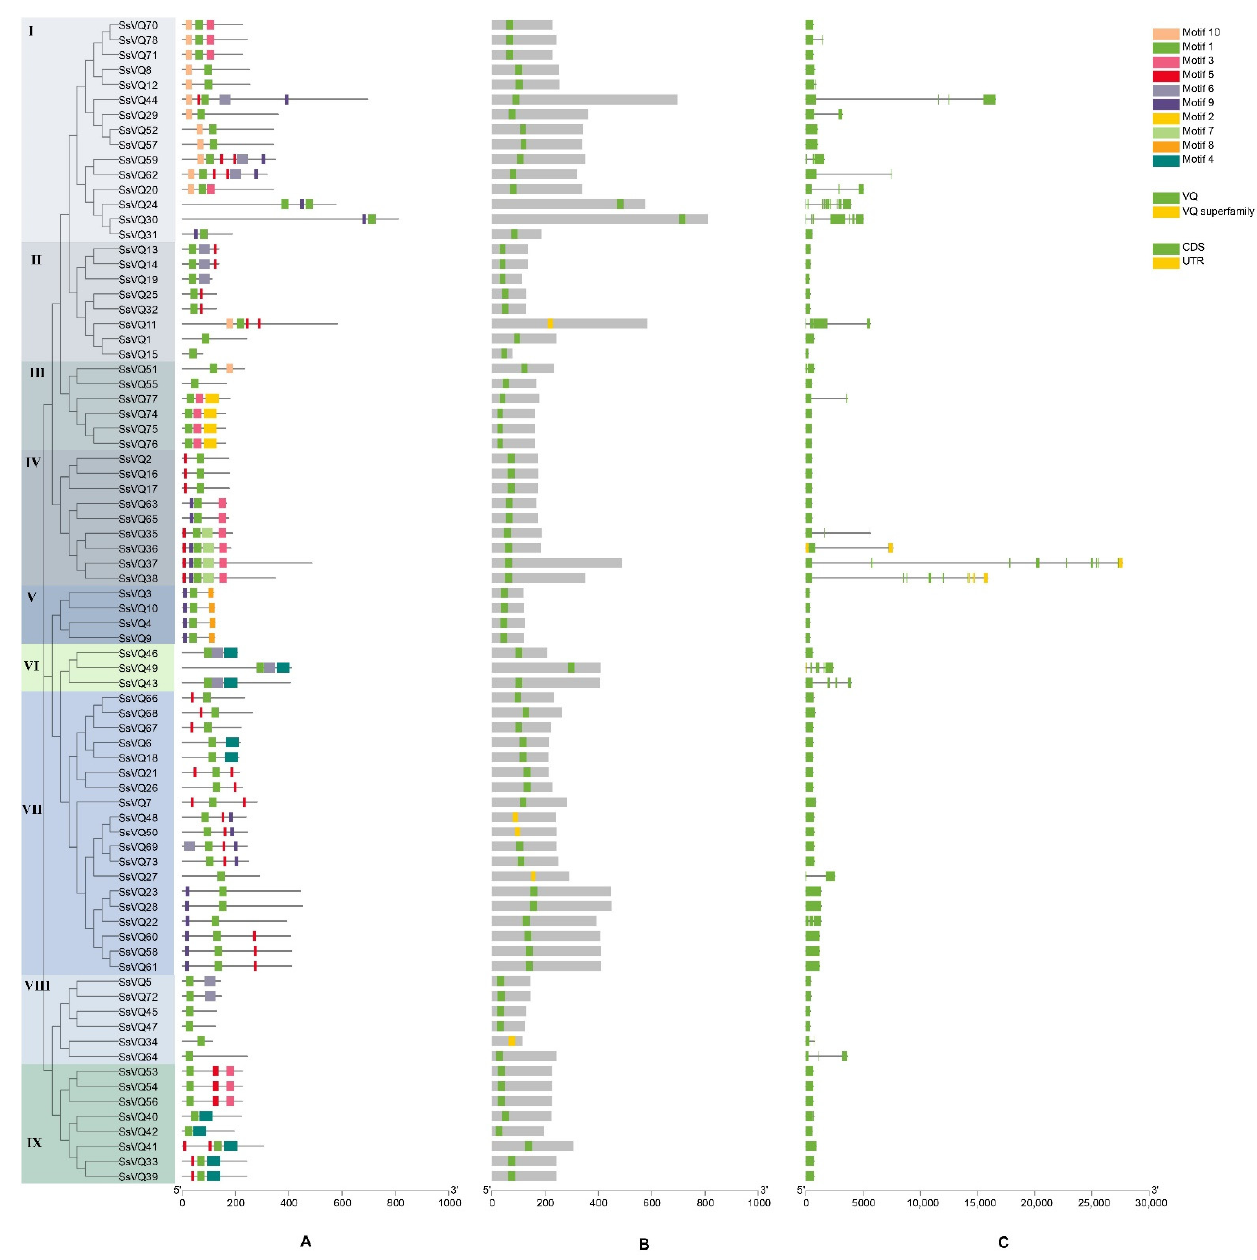
Figure 3. Phylogenetic tree, conserved motif, conserved domain, and the gene structure of the VQ genes. The phylogenetic tree was constructed using MEGA X software based on VQ protein sequences. ( A ) Conserved motifs of the VQ proteins. Each motif is represented with a specific color. ( B ) The conserved domain of VQ protein. The green and yellow boxes represent the VQ domain. ( C ) Gene structure of VQ gene. The untranslated 5 (cid:48) - and 3 (cid:48) -regions, introns and exons are represented with yellow box, green box and black lines,